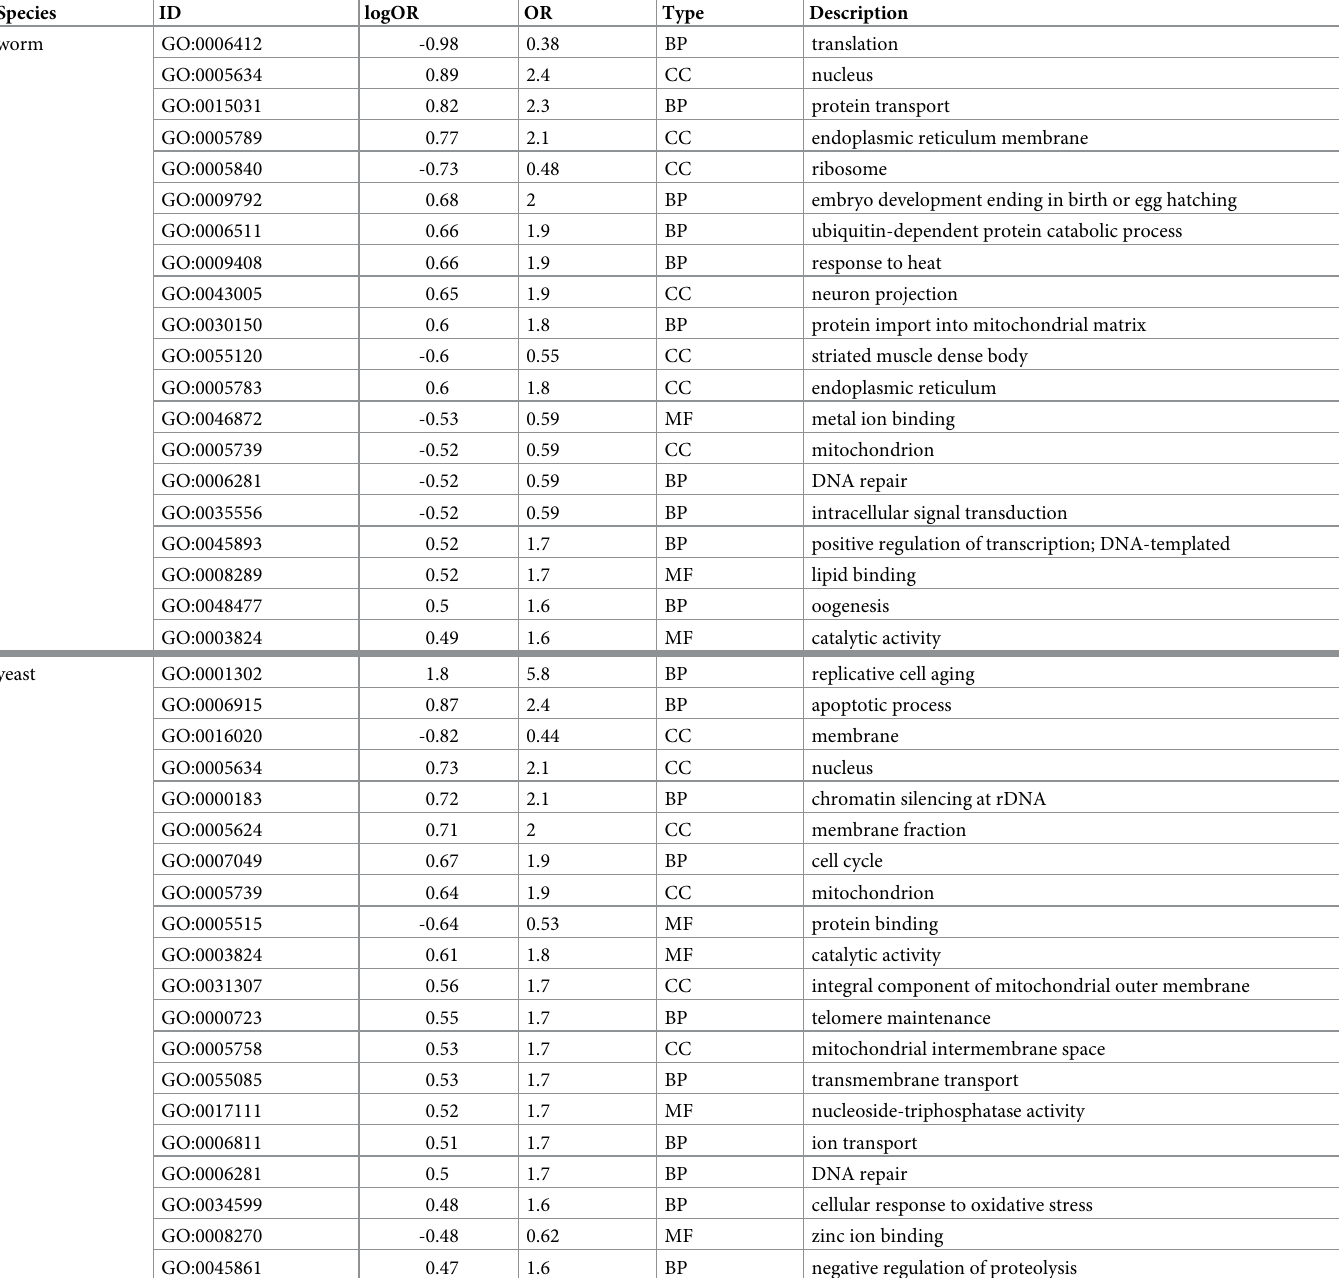
Table 2. Top GO terms identified by the pglm (GLM-Net) algorithm. logOR: log-odds ratio. OR: odds ratio. Positive logOR indicates a gene annotated to that GO term is more likely to be pro-longevity. BP: biological process, CC: cellular component, MF: molecular function.